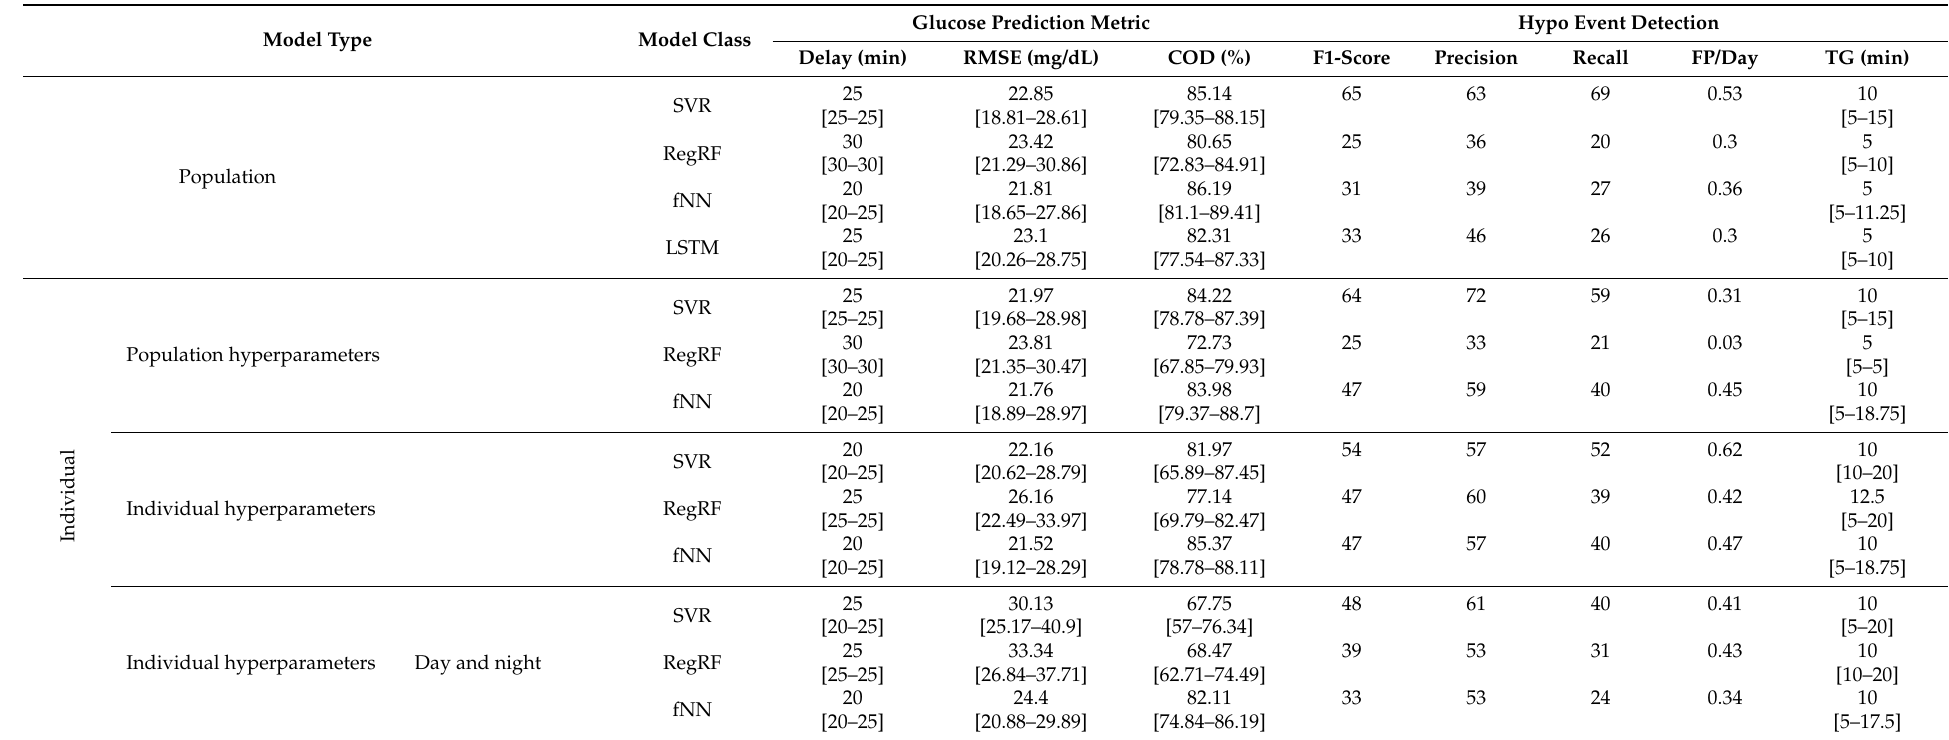
Table 3. Performance of nonlinear algorithms with a representative dataset partitioning (30-min